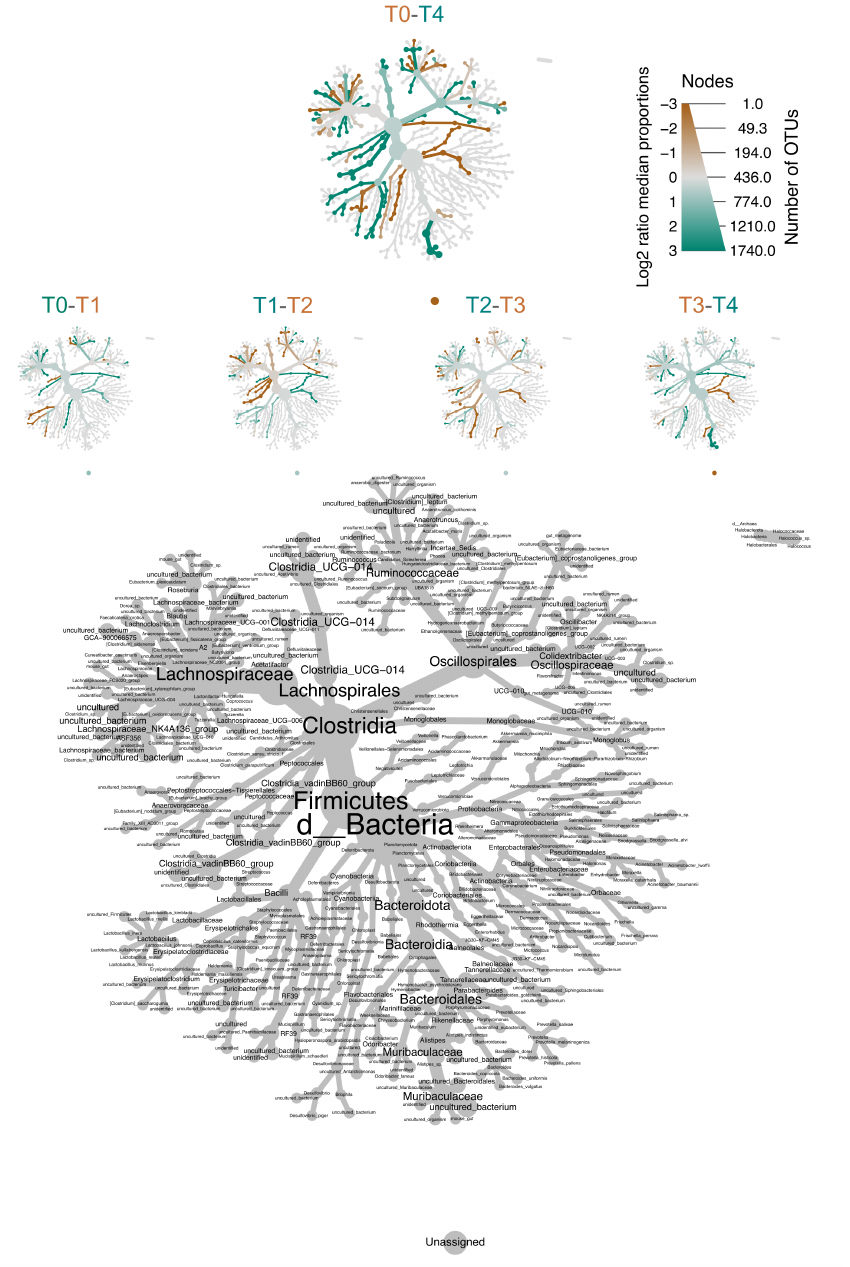
Figure 6. A differential heat tree based on the Wilcoxon rank-sum test, indicating which taxa were more abundant in each experimental time. Phyla, classes, orders, families, and genera are represented. Node label is the taxon name, node size is the number of ASVs, and node color is the abundances of the indicated phylum, class, order, family, or genus. A taxon colored brown was more abundant in the time points colored in brown and a taxon colored in green was more abundant in the time points colored in green, as reported in the legend. The tree differential plots were generated using the metacoder R package. (Number of animals: T1 n = 14, T2 n = 12, T3 n =14, and T4 n